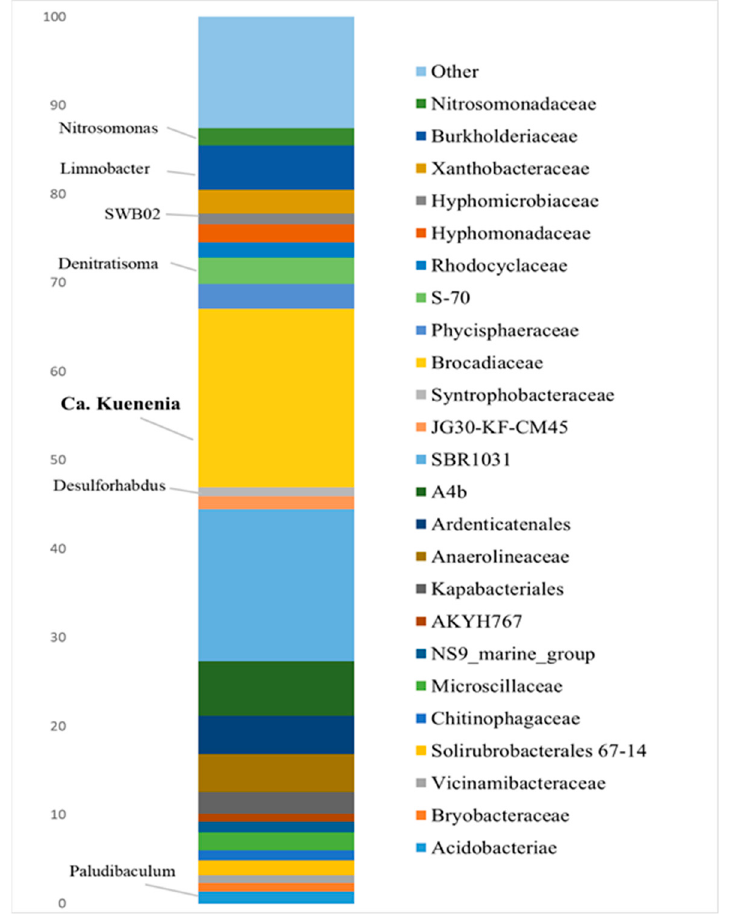
Figure 2. Taxonomic diversity of a “warm” anammox bioreactor community at the family and genus level, based on 16S rRNA gene sequencing.